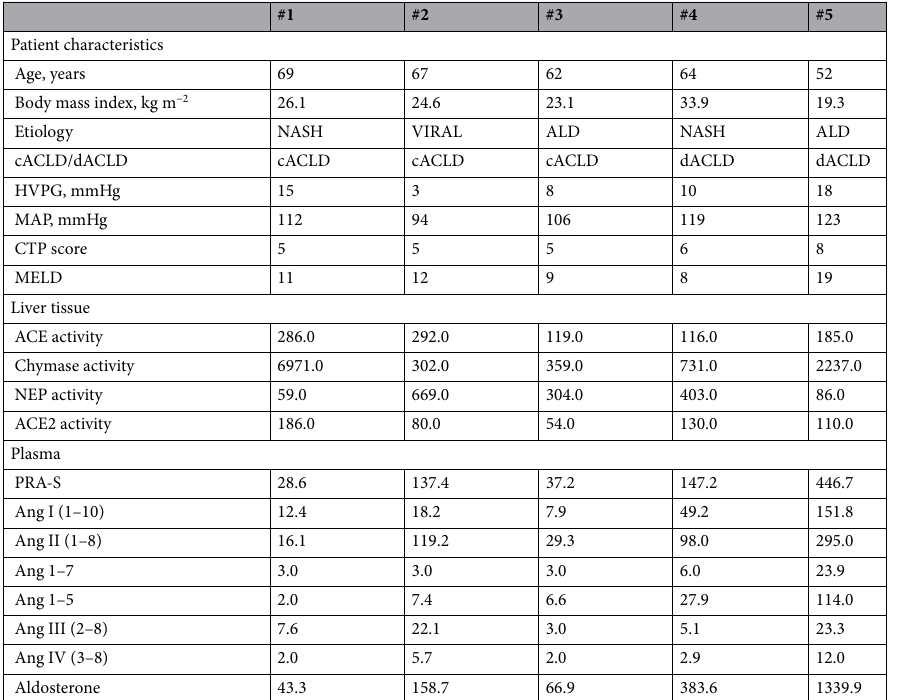
Table 4. Hepatic and systemic RAS components in liver tissue samples and plasma samples of 5 ACLD patients (#1–5). In the liver tissue, activity of ACE and chymase as enzymes of the classical RAS and ACE2 and NEP as enzymes of the non-classical RAS were assessed. In plasma, levels of classical (PRA-S, Ang I, Ang II, aldosterone) and non-classical RAS (Ang 1–7, Ang III, Ang IV, Ang 1–5) were quantified. ACE angiotensin converting enzyme, Ang angiotensin, cACLD compensated advanced chronic liver disease, CTP Child– Turcotte–Pugh, dACLD decompensated advanced chronic liver disease, HVPG hepatic venous pressure gradient, MAP mean arterial pressure, MELD model for end-stage liver disease, NEP neprilysin, PRA-S plasma renin activity surrogate, RAS renin–angiotensin